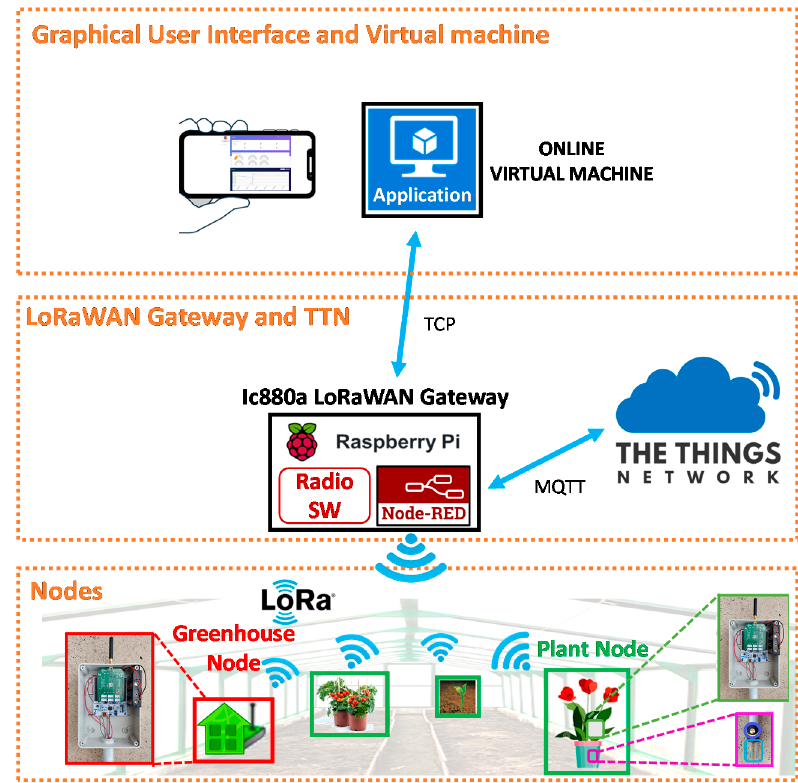
Figure 1. System